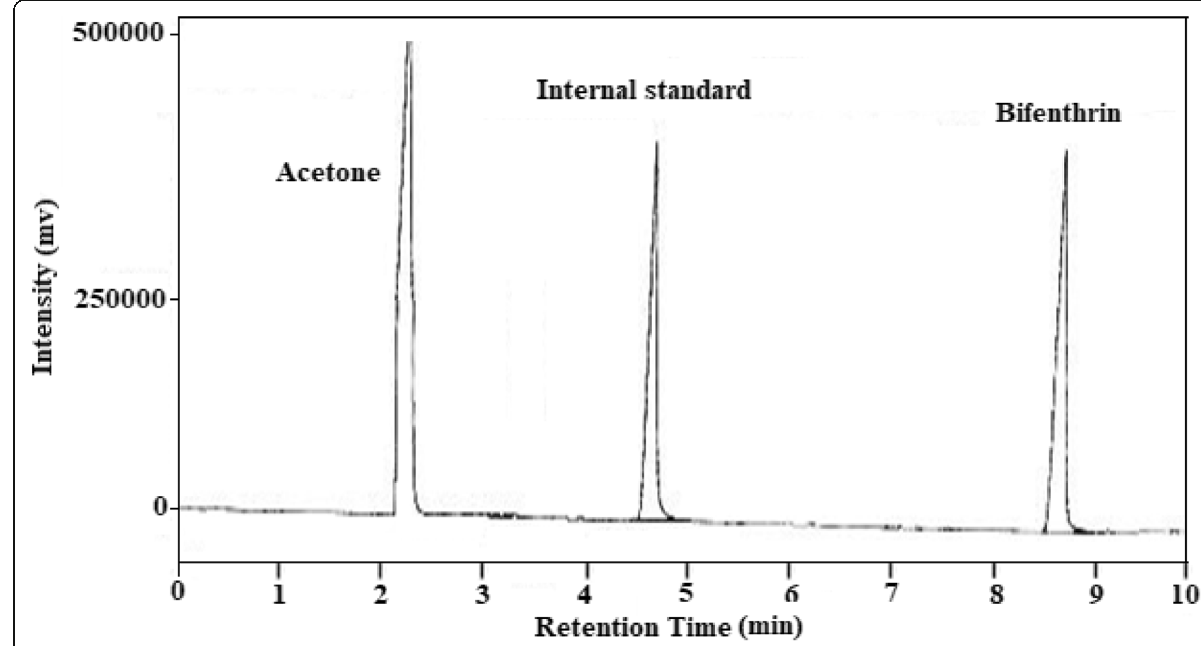
Fig. 4 Representative gas chromatogram showing the specificity and selectivity of the